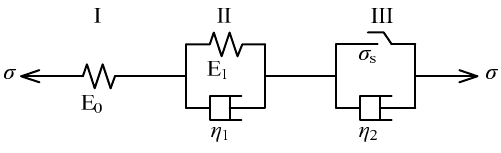
Figure 1. The Nishihara model.